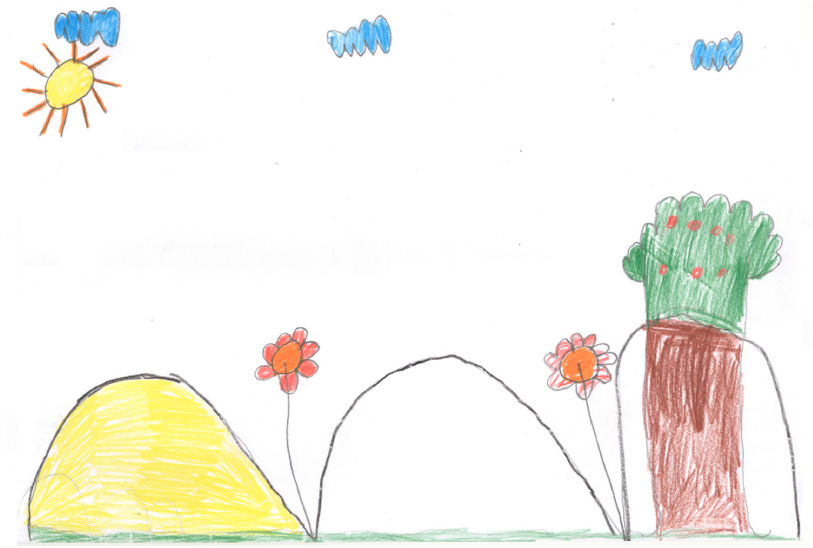
Figure A1. A spontaneous drawing depicted by a 7-year-old child.